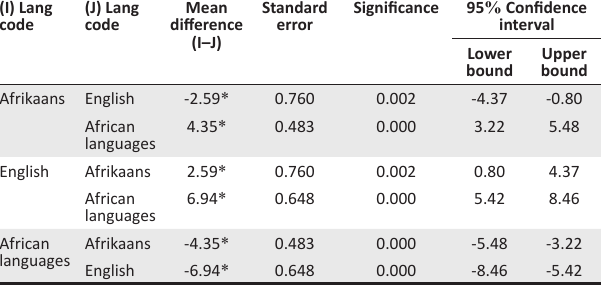
FIGURE 3: Estimated marginal means plot for gender and language groups. TABLE 8: Multiple comparisons for the language groups (Turkey post hoc